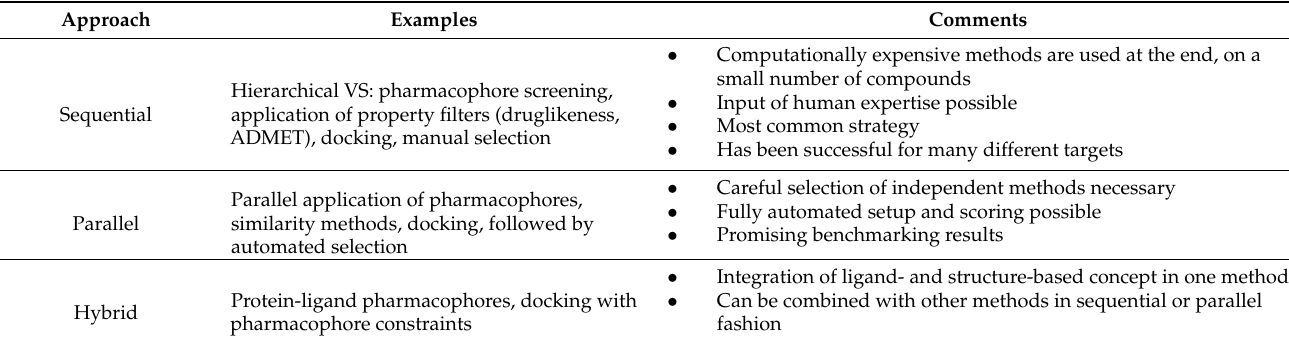
Table 2. Combined ligand and structure-based methods (adapted from [10], with permission).